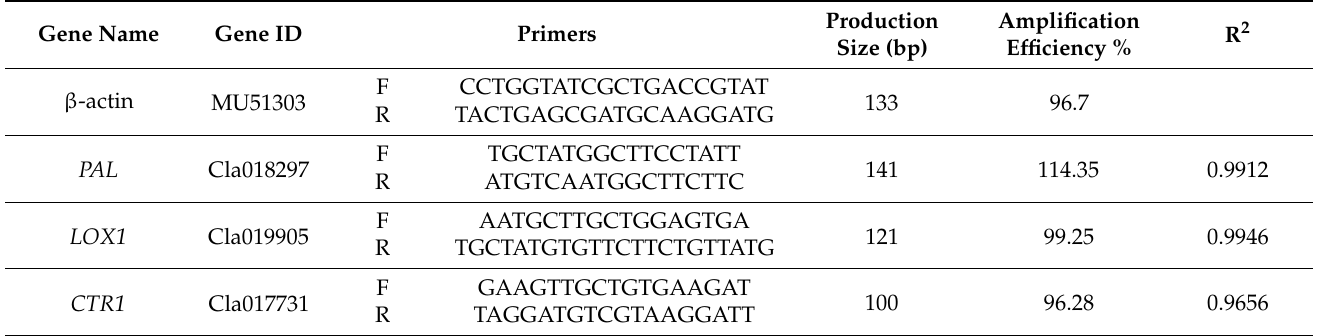
Table 3. The primers for